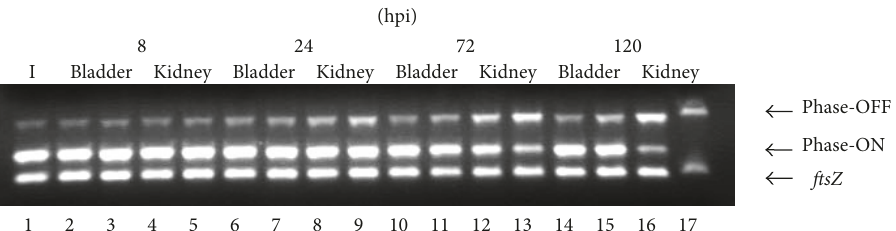
Figure 4: Determination of the fimS invertible element orientation by PCR on chromosomal DNA isolated from NU149 grown in LB as well as NU149 infected murine bladder and kidney homogenates spanning a five-day infection period. Two random different UPEC infected murine bladder and kidney homogenates were screened for each time point. Multiplex PCRs were set up with INV and FIMA primers to amplify Phase-ON-oriented DNA (ON, 450 bp product) [28], FIME and INV primers to amplify Phase-OFF-oriented DNA (OFF, 750 bp product) [41], and EcFtsZ 1 and 2 primers to amplify the ftsZ gene (302 bp product) [45]. Each multiplex was run at least three separate times. The lanes were loaded onto a 1.5% agarose gel as follows: lane 1, NU149 inoculum; lane 2, NU149 infected bladder mouse 1 day 0.33; lane 3,